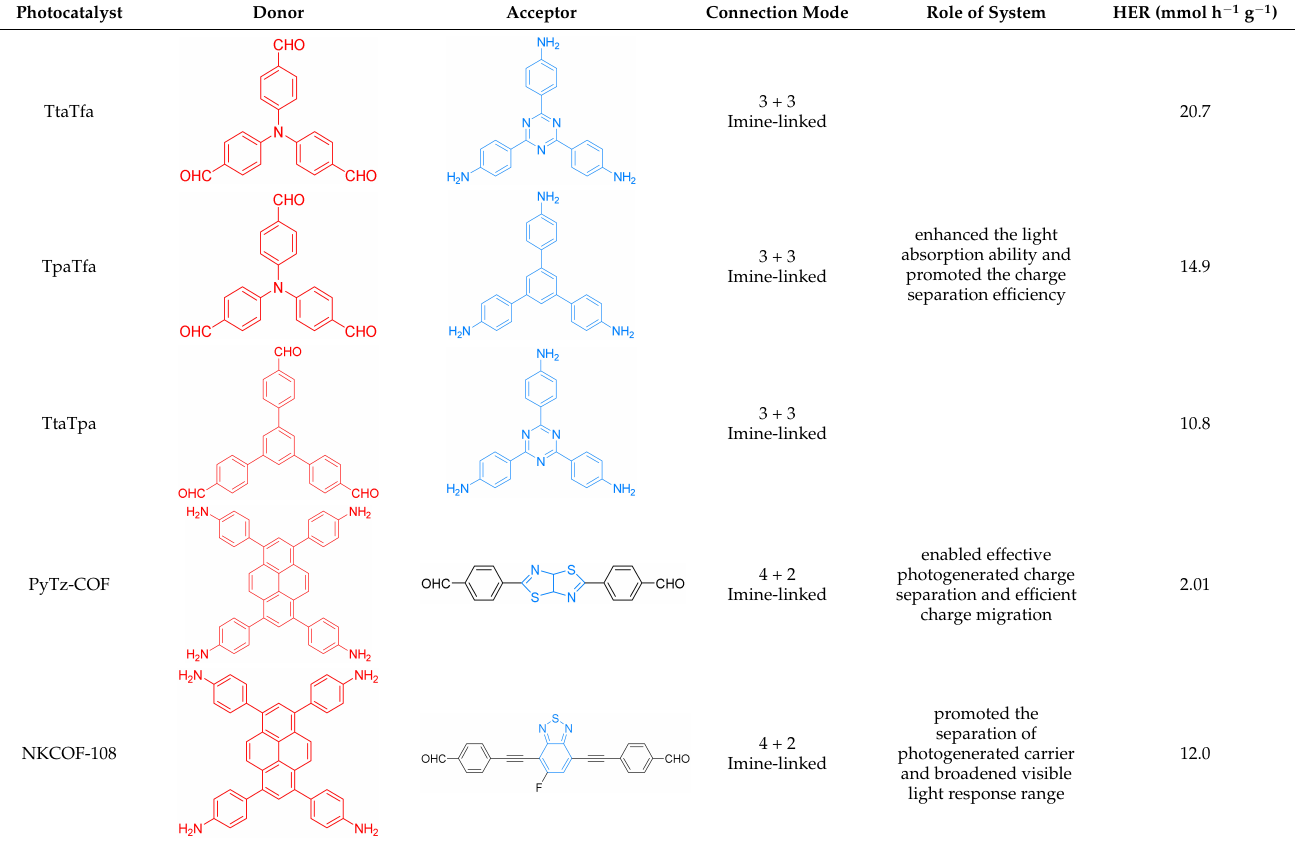
Table 1. Summary of different structure units of D-A COFs containing for H 2